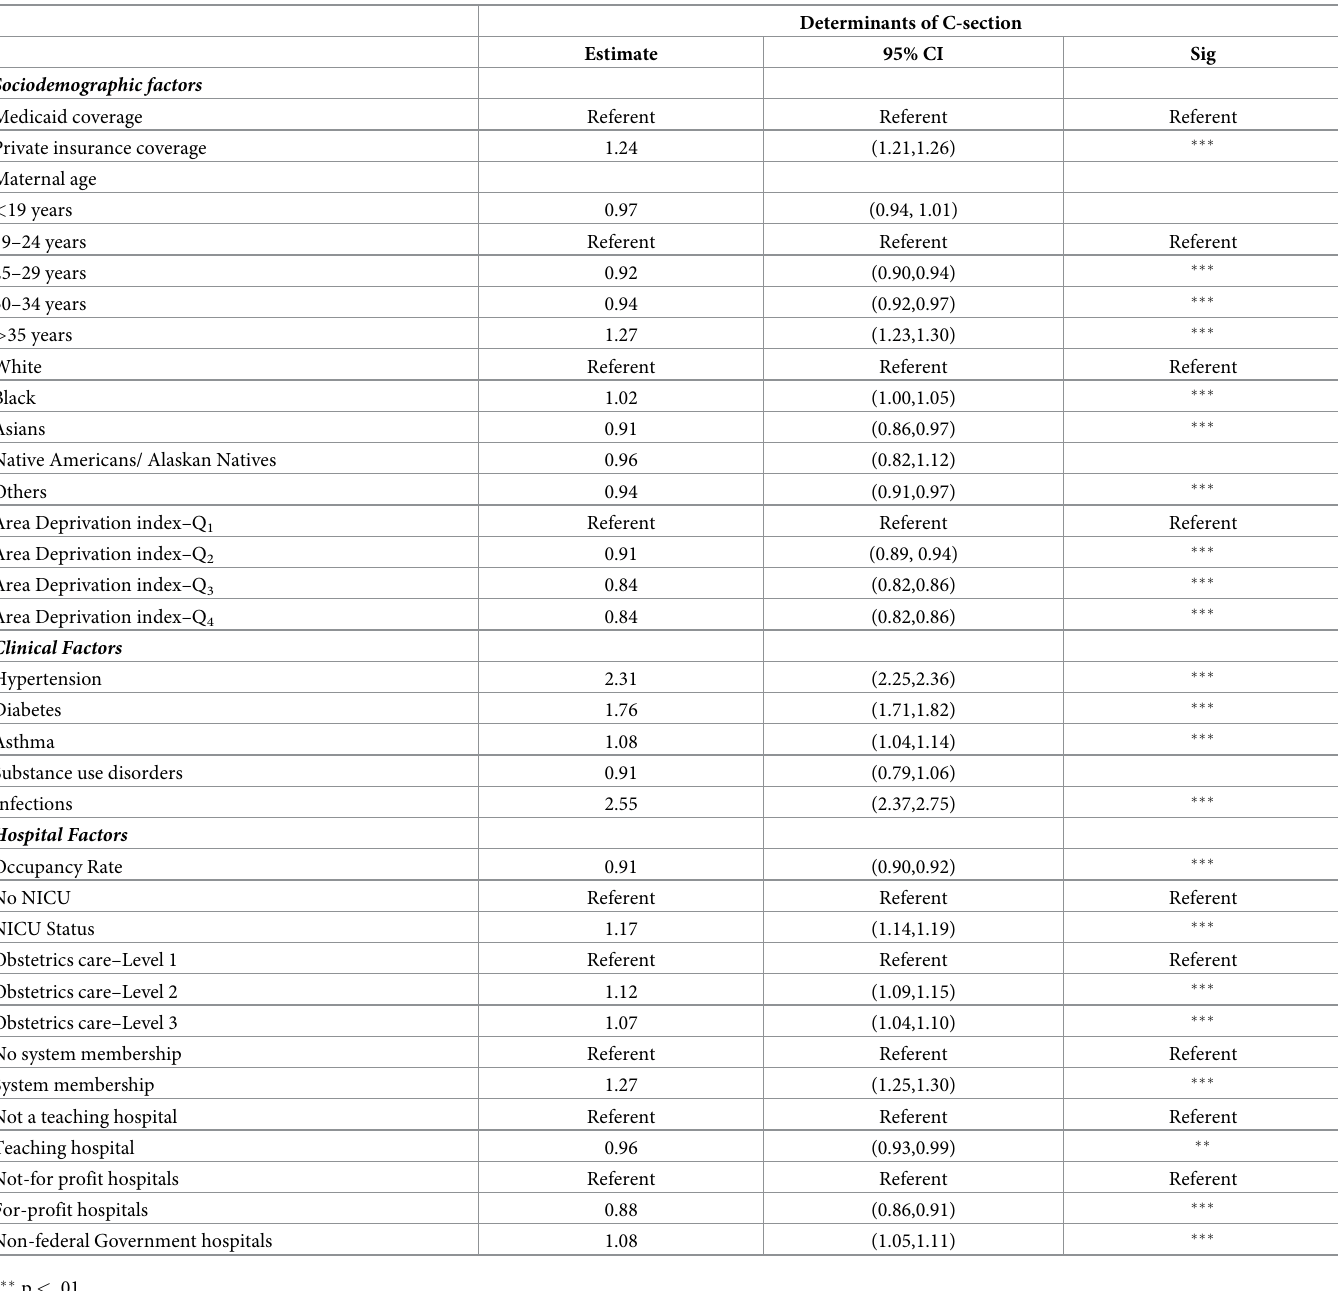
Table 2. Determinants of NTSV low-risk C-sections at hospital discharge, 2010–2015 (n =